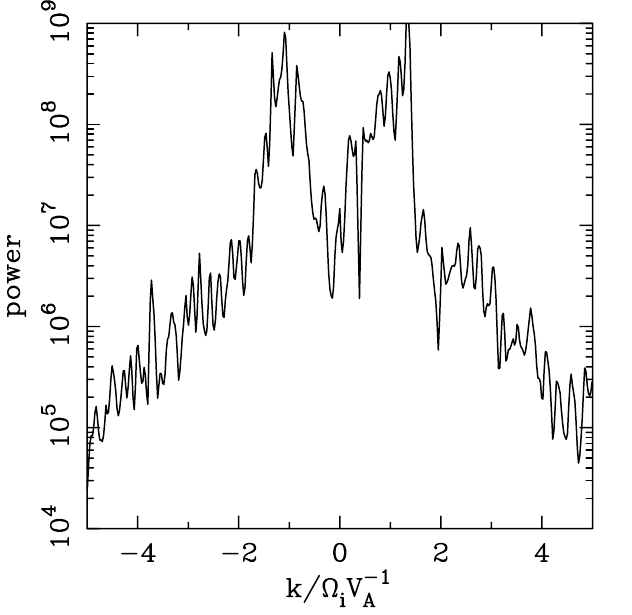
Fig. 6. Fourier transform of the B z magnetic field component for a field slice running along the shock overshoot ( x = 2 v A (cid:127) − 1 = 88 ◦ , M A ≈ 5 . 7 θ B n